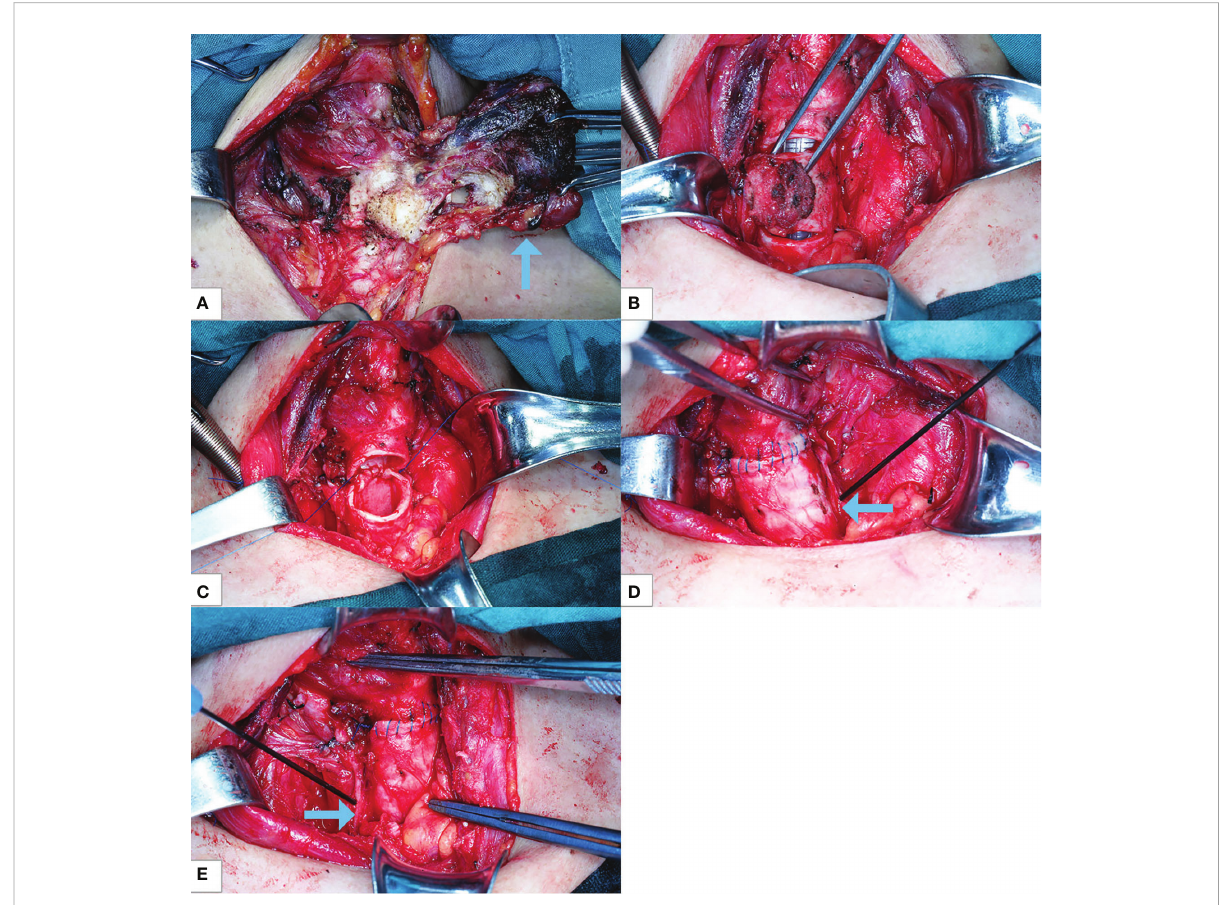
FIGURE 2 Intraoperative photographs. (A) Thyroid cancer invades the trachea (arrow). (B) The second and third tracheal rings and tumors are annularly resected with tracheal intubation ventilation condition. (C) The trachea end-to-end sleeve anastomosis is ongoing with ECMO ventilation. (D) The anastomosis is completed, with left recurrent laryngeal nerve with nerve detection and protection (arrow). (E) Right recurrent laryngeal nerve with nerve detection and protection (arrow). ECMO, extracorporeal membrane